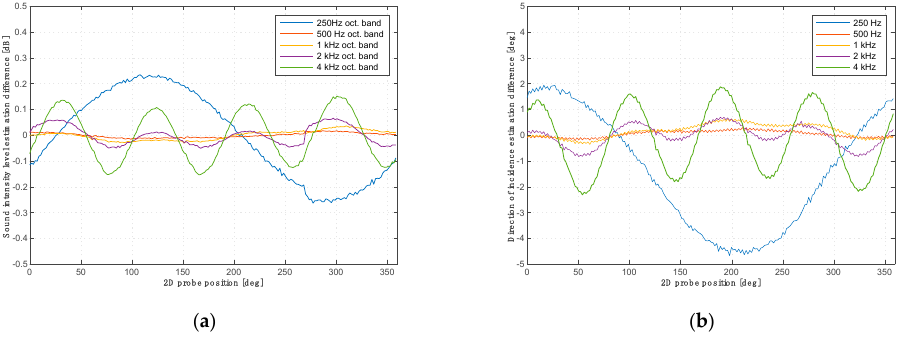
Figure 7. Variations of sound intensity magnitude ( a ) and deviation of the indicated angle from the nominal value ( b ) for the two-microphone probe for the subsequent angular positions of the probe.